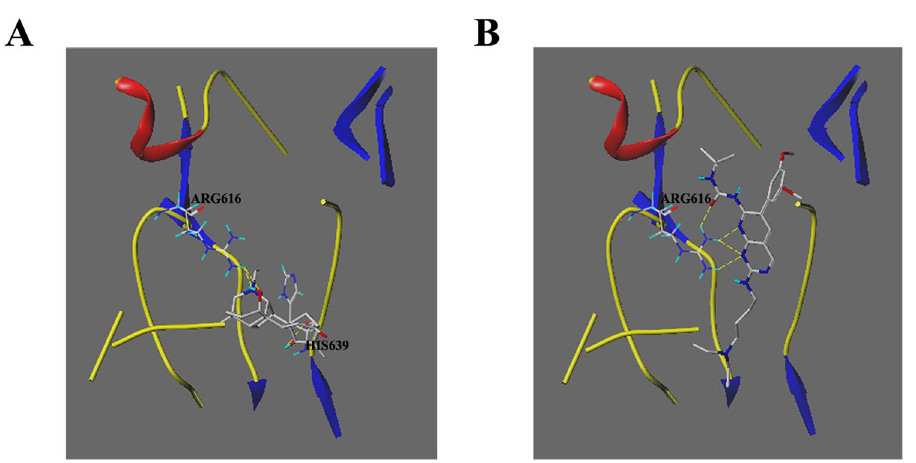
Figure 8. Binding models of ( A ) napellonine and ( B ) PD with FGFR4 (PDB ID: 4TYE). Napellonine and PD were colored based on atom types (carbon: gray; oxygen: red; nitrogen: blue). Yellow dotted lines stood for hydrogen bonds, The key residues were marked in